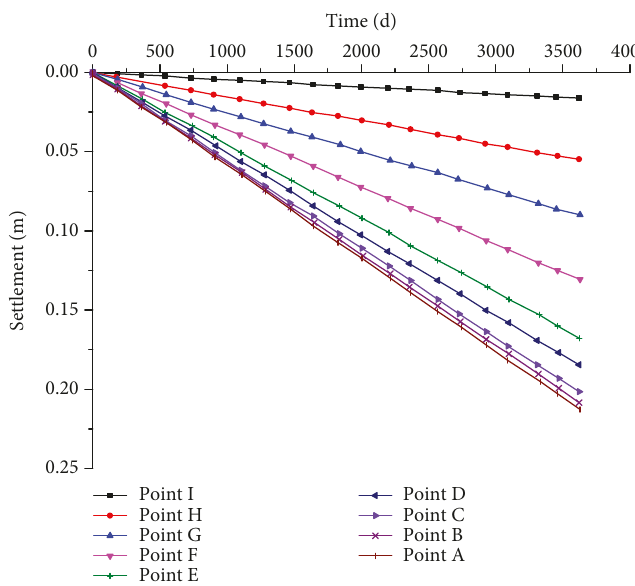
Figure 12: Ground settlement changing with time in case Π -01.